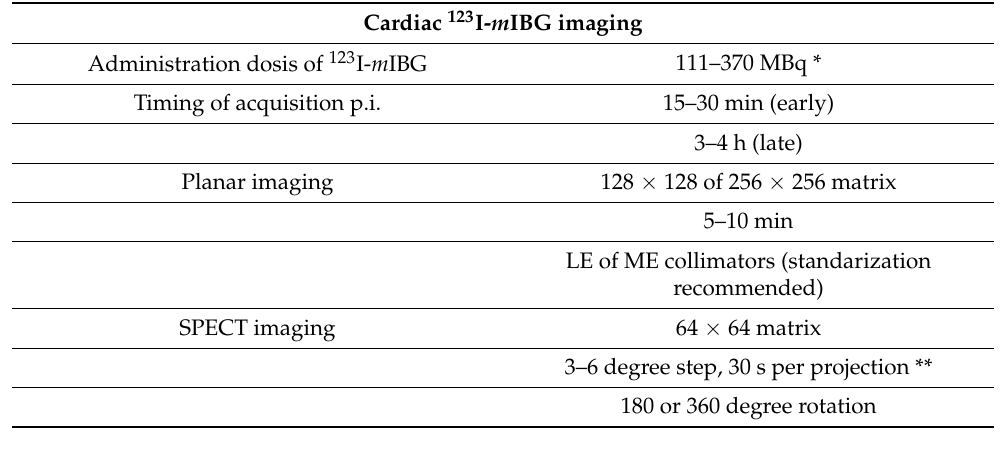
Table 2. Recommended cardiac 123 I- m IBG imaging acquisition conditions. * standard dose of 123 I- m IBG varies among countries; 111 MBq in Japan, 185 MBq in Europe, and 370 MBq in the USA. ** Total acquisition time 20–30 min with anger camera and 10 min with cardiac CZT camera.